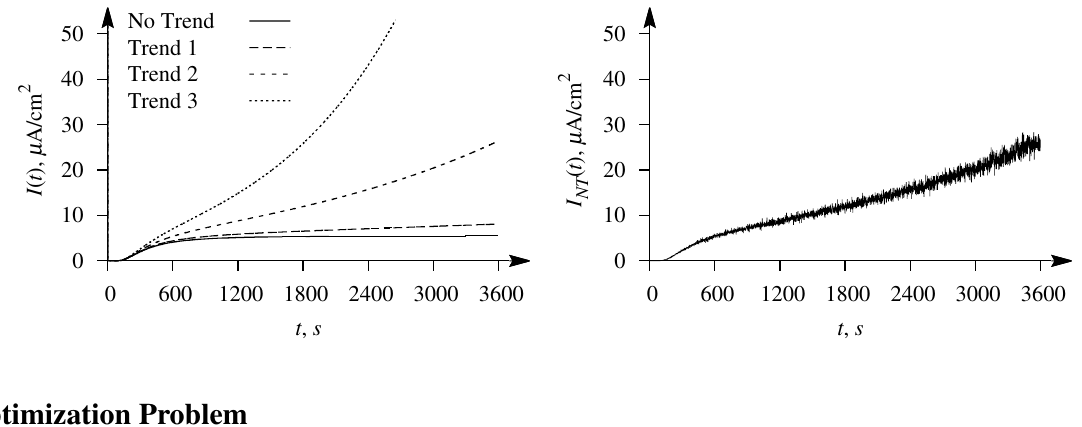
Figure 2. The dynamics of the biosensor current affected by the exponential trends ( Left ) and in conjugation with the white Gaussian noise ( Right , σ = 0 . 05 ) simulated at the following values of the model parameters: V S = 1 . 28 mM . The other parameters are as defined in Equation 2 , 0